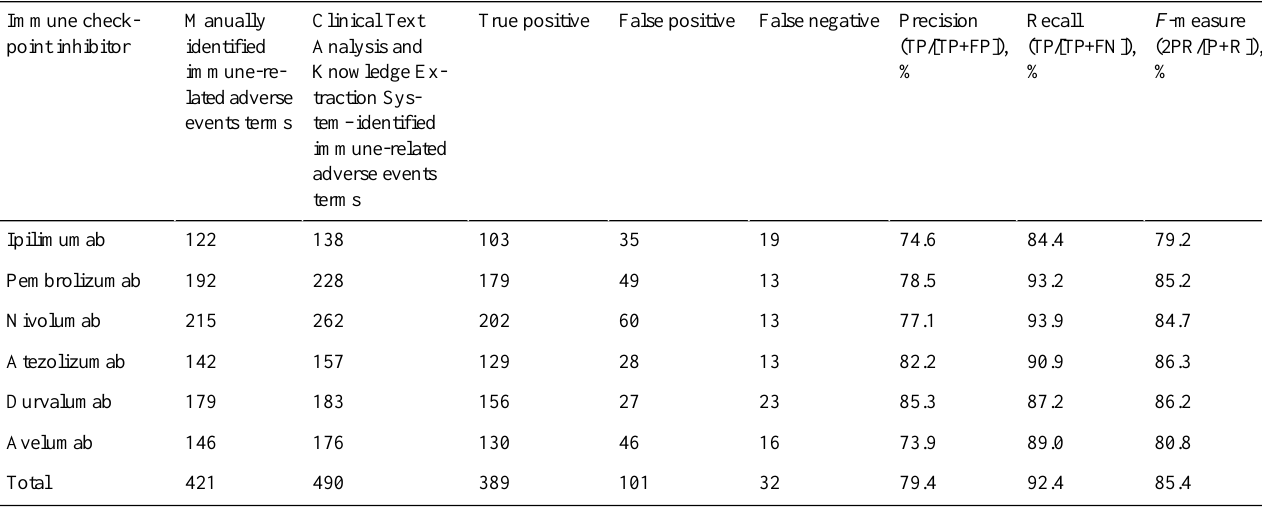
Table 6. Performance of text-mining pipeline for the identification of immune-related adverse events from drug labels of 6 immune checkpoint inhibitors.